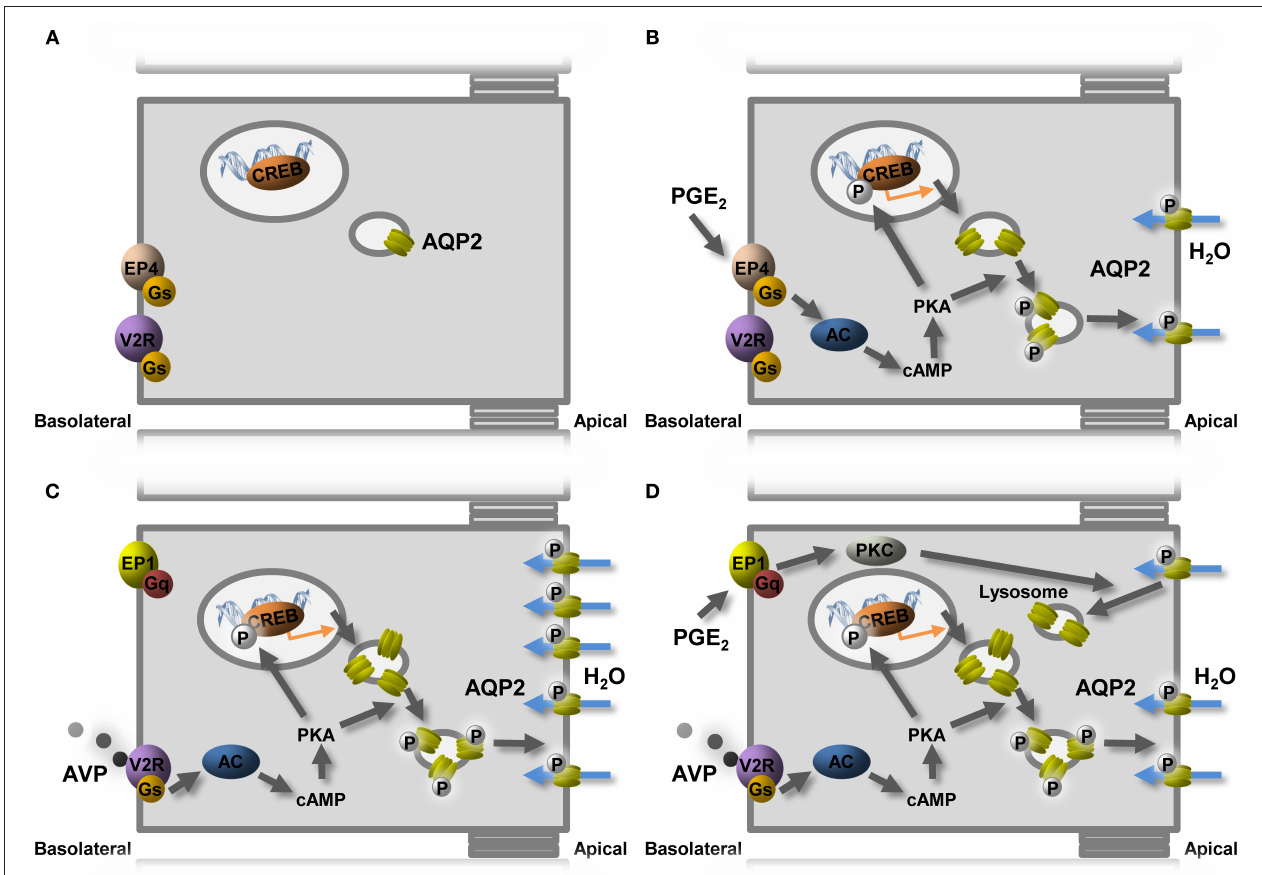
FIGURE 6 | Model of PGE 2 -mediated regulation of AQP2-mediated water reabsorption. (A) In the absence of AVP, the AQP2 expression is low and present in intracellular vesicles. (B) PGE 2 stimulates water reabsorption by binding to the EP4 receptor, coupling to the Gs protein, leading to cAMP generation, followed by AQP2 transcription and translocation. (C) AVP increases the expression of AQP2 but also induces the expression of the AVP-counteracting EP1 receptor and reduces EP4. (D) In the presence of AVP, PGE 2 decreases the AQP2 expression by stimulating EP1. Indicated are AC, adenylate cyclase; AQP2, aquaporin-2; AVP, vasopressin; cAMP, cyclic adenosine monophosphate; PKA, protein kinase A; PKC, protein kinase C; V2R, vasopressin V2 receptor.